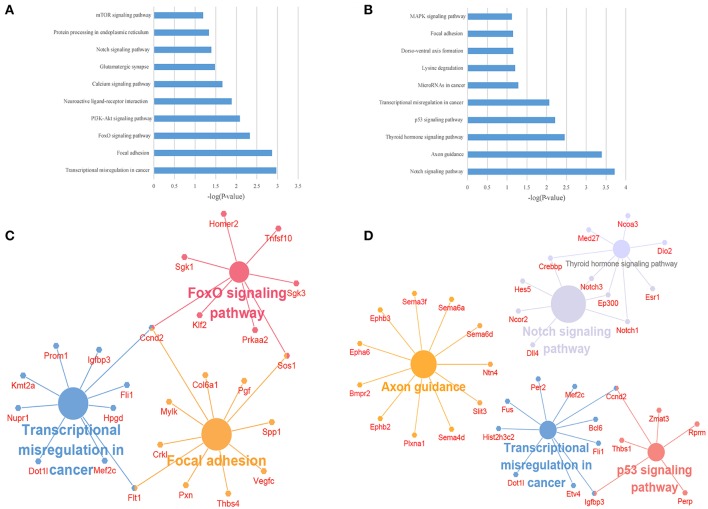
The KEGG pathway enrichment analysis on target genes of differentially expressed lncRNAs. (A,B) The top 10 enrichment scores in the KEGG pathway analysis of the target genes of the up-regulated (A) and down-regulated (B) lncRNAs; (C,D) The network of most enriched pathways of the up-regulated (C) and down-regulated (D) lncRNAs and related genes.